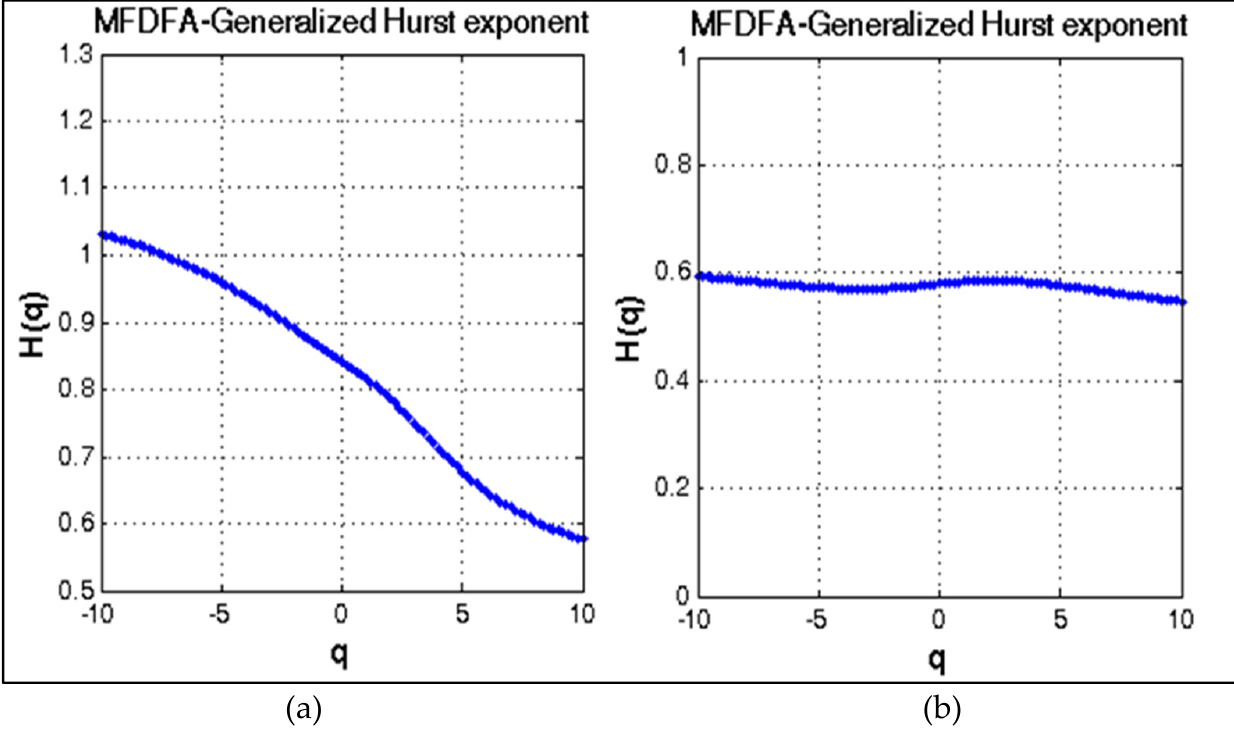
Table 3. Comparison between healthy and unhealthy subjects .